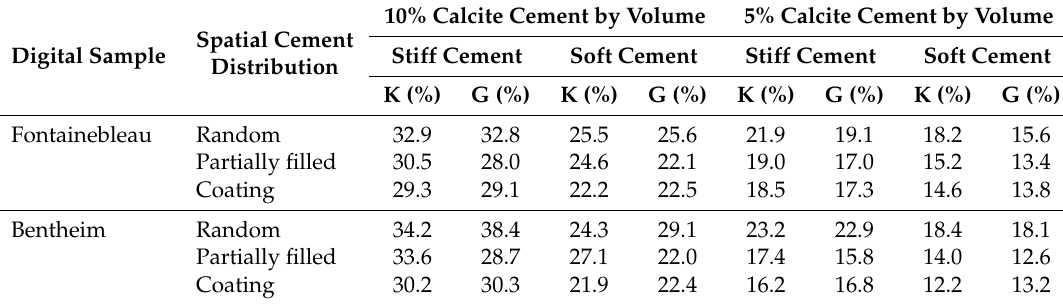
Table 4. Percentage reduction in bulk (K) and shear (G) moduli resulting from the removal of calcite.